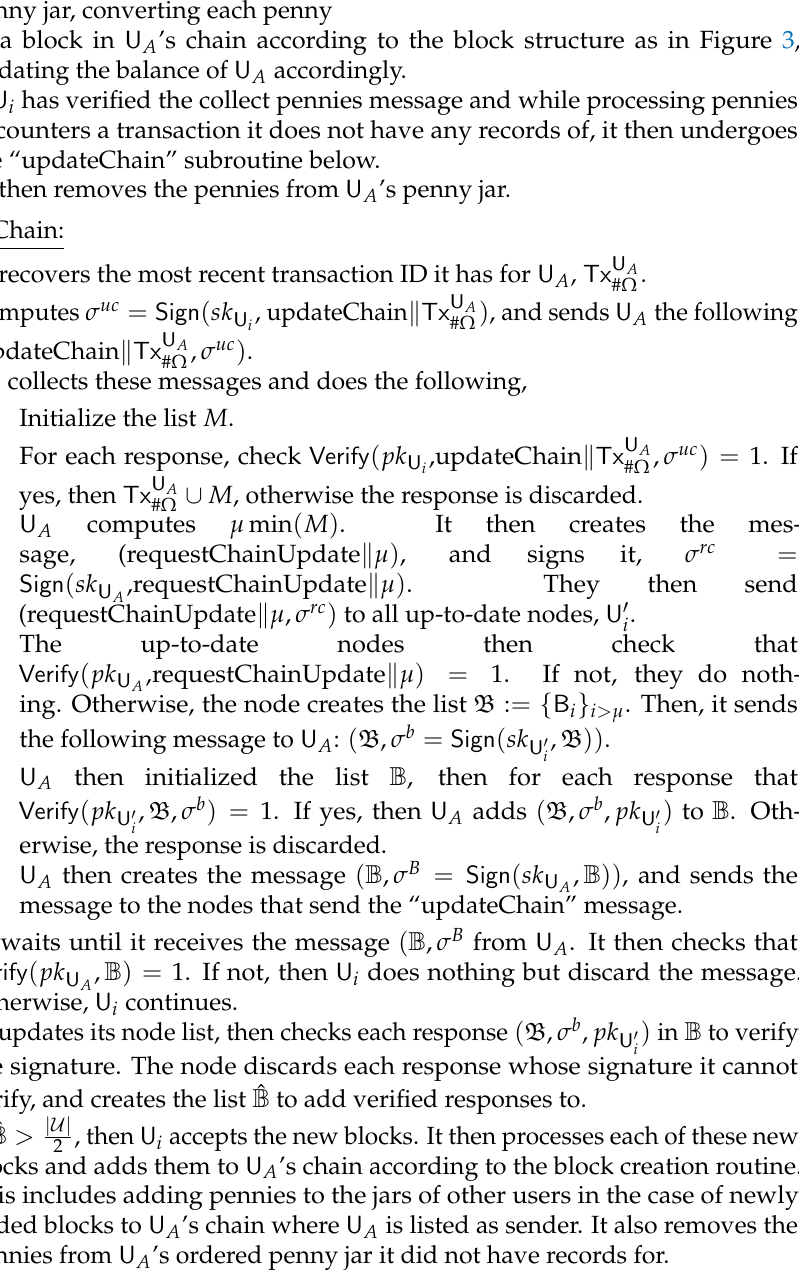
Figure A9. Verification of CollectPennies by U i and updating U A ’s